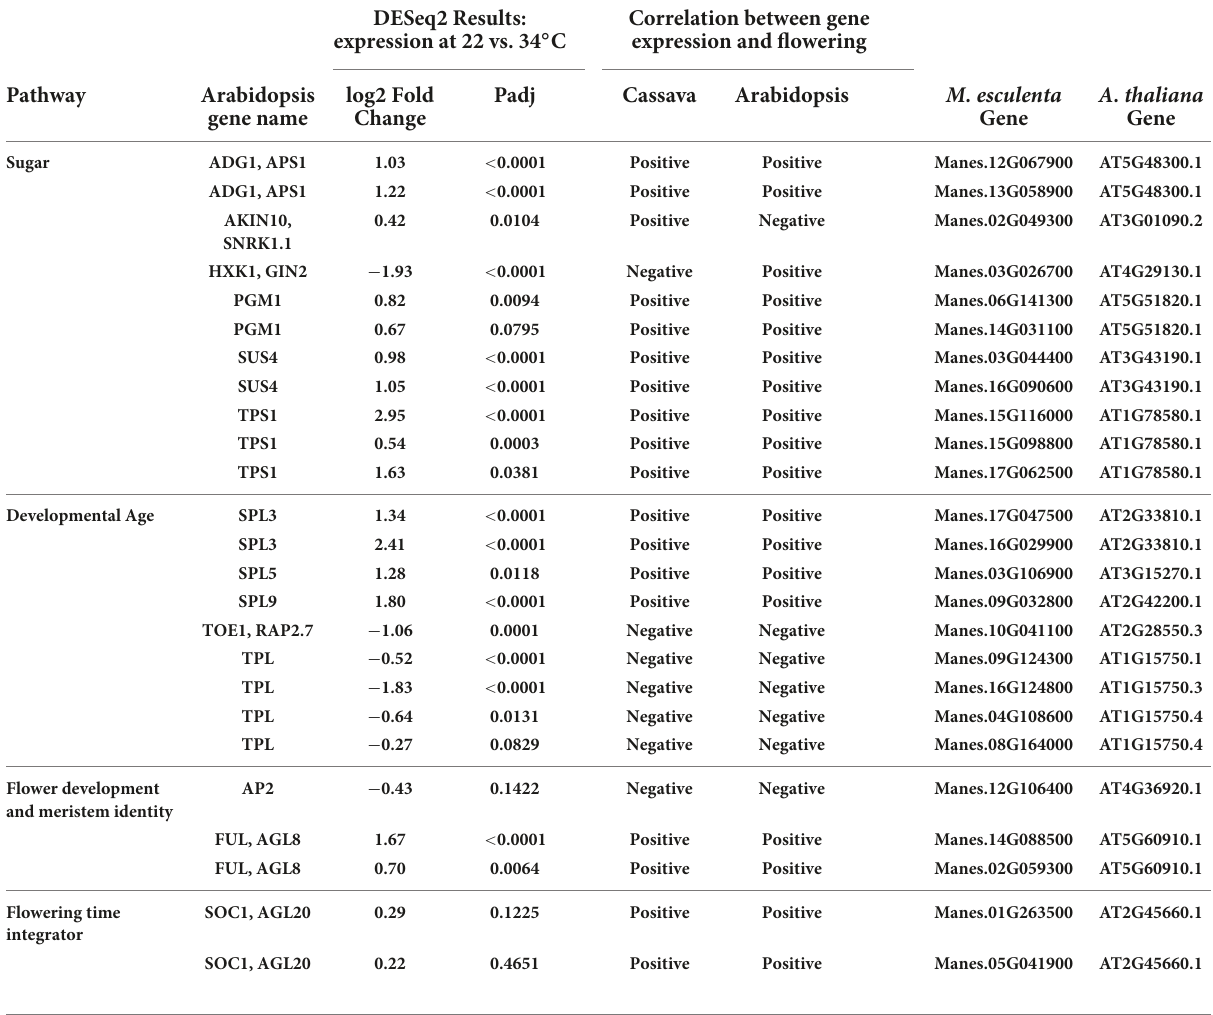
TABLE 3 Significant differentially expressed genes (DEGs) and log2 Fold Change from flowering pathways showing the most similarity to flower regulation in A thaliana and relevant down stream genes part of the flower development and meristem identity and flowering time integrator